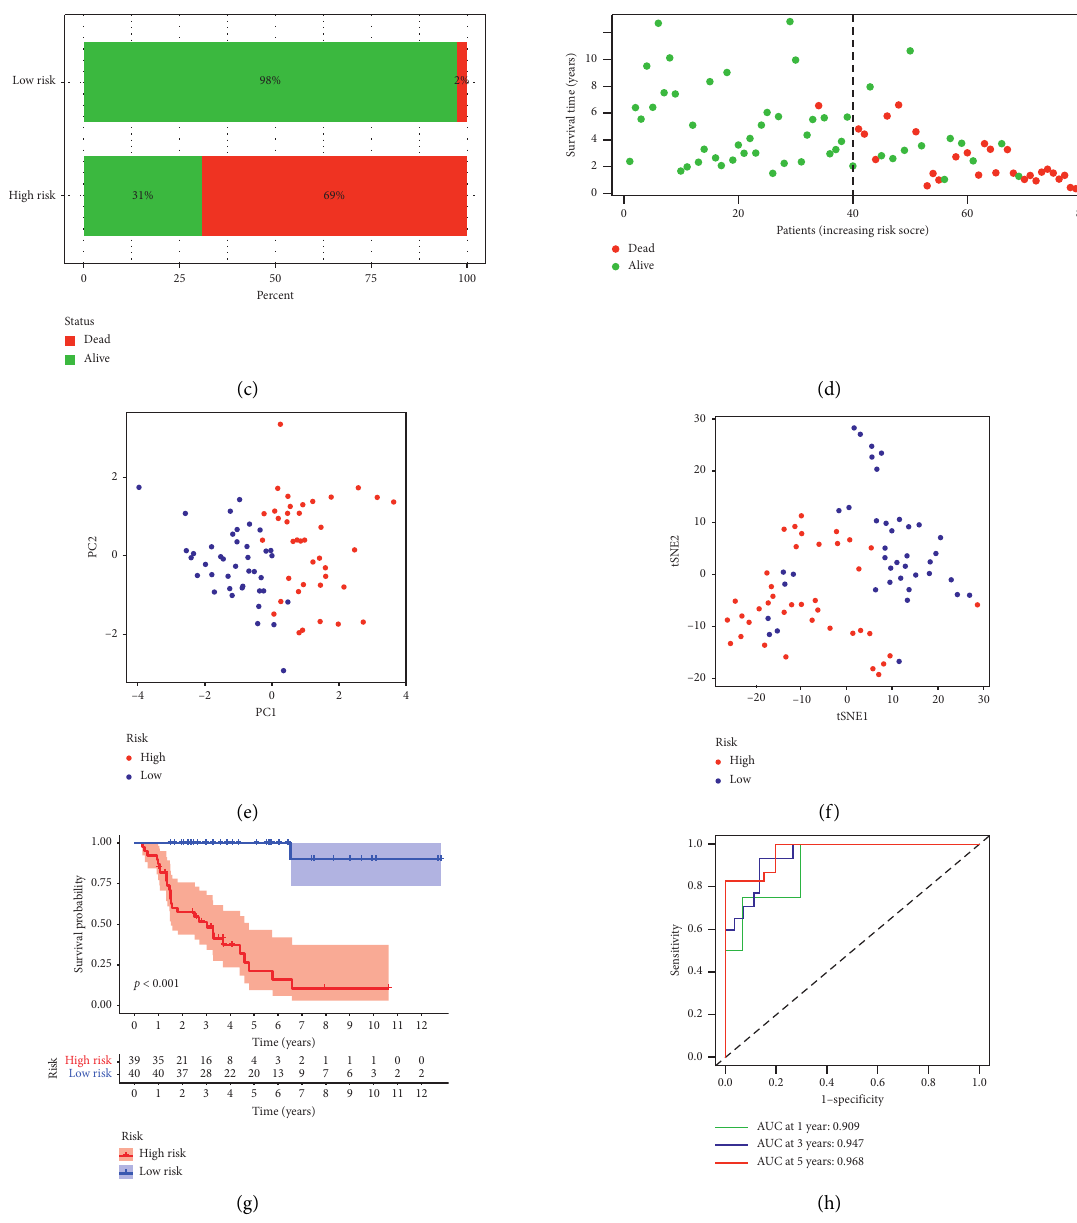
Figure 2: Prognostic value of the ferroptosis risk signature in TCGA. (a) Heatmap of the 6 ferroptosis-associated genes in two groups. (b) The distribution and median value of the risk scores. (c), (d) The mortality in two groups. (e) The PCA plot. (f) The t-SNE analysis. (g) K-M curves for the OS of patients in two groups. (h) ROC curve for assessing the predictive efficiency of the risk